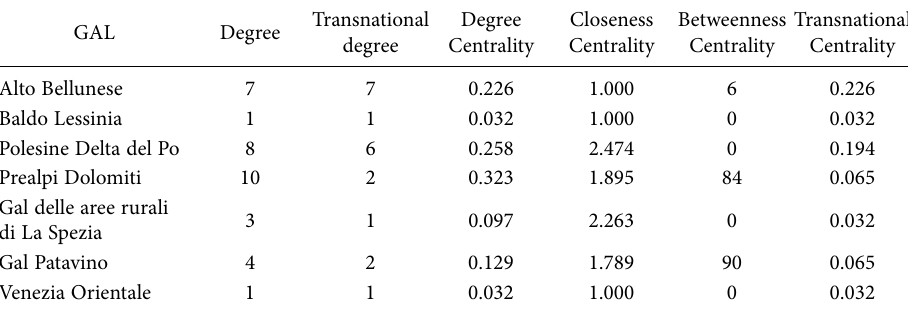
Table 8. Indexes of the transnational cooperation network of Veneto LAGs, by node, LEADER +.